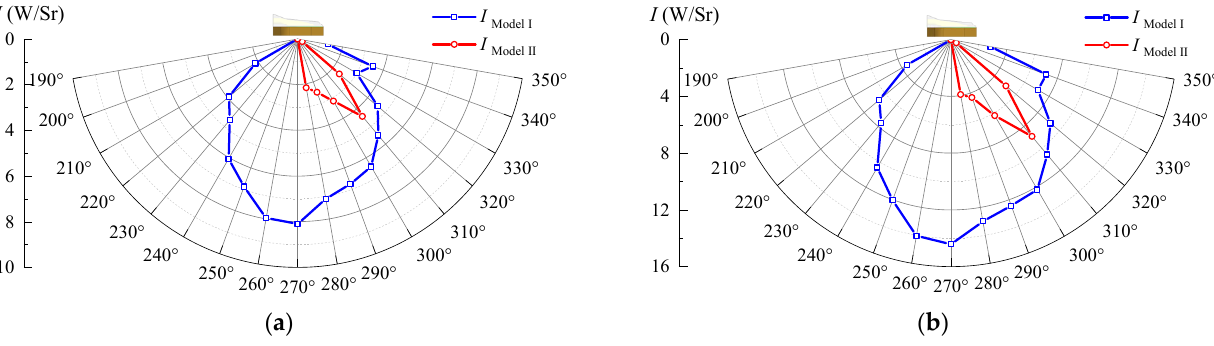
Figure 26. Infrared radiation intensity of mixing duct. ( a ) 3–5 µm band; and ( b ) 8–14 µm band.